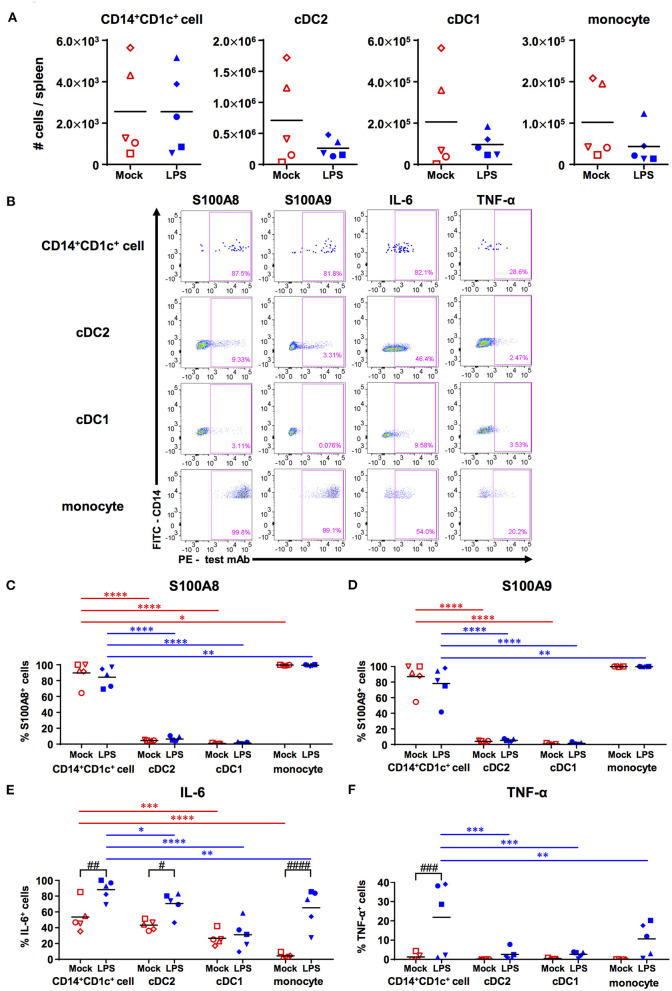
Responsiveness of human dendritic cell populations in hNOJ mice against LPS-induced acute inflammation. Cells were prepared from the spleen of IVT-hNOJ mice following intraperitoneal LPS injection. (A) Individual absolute cell numbers of CD14+CD1c+ cells, cDC2s, cDC1s, and monocytes within human CD45+ cells (Mock: n = 5, LPS: n = 5). The Mann-Whitney U test was used, and no significant differences were observed. The distinct symbols show each separate hNOJ mouse. (B) Representative flow cytometry profiles of intracellular inflammation-related proteins/cytokines (S100A8, S100A9, IL-6, and TNF-α) in cell populations. (C–F) Individual percentages of the cells expressing (C) S100A8, (D) S100A9, (E) IL-6, and (F) TNF-α (Mock: n = 5, LPS: n = 5). Significant differences (*P < 0.05, **P < 0.01, ***P < 0.001, ****P < 0.0001) between CD14+CD1c+ cells and each other subset under the same conditions (red: mock, blue: LPS) were determined using the repeated-measures two-way ANOVA followed by the Holm-Sidak's multiple comparison test. In addition, significant differences (#P < 0.05, ##P < 0.01, ###P < 0.001, and ####P < 0.0001) between Mock and LPS conditions in same cell subsets were determined by repeated-measures two-way ANOVA followed by the Holm-Sidak's multiple comparison test. The distinct symbols show each separate hNOJ mouse.